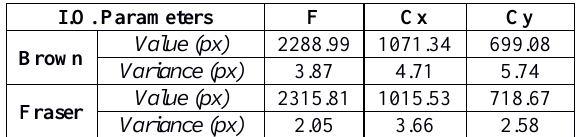
Table 1. Comparison of the estimated values and uncertainties (in pixels) of the focal length and the coordinates of the principal point for the employed calibration